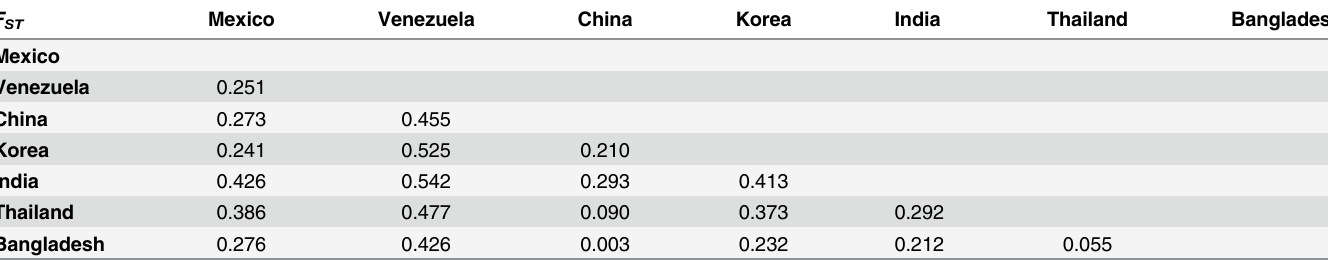
Table 5. Pairwise F ST indices of inter-population variance for the pvs28 gene.